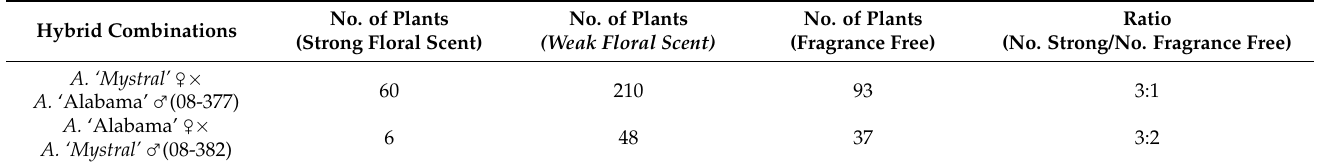
Table 2. Olfactory test of F1 hybrids from two-hybrid combinations.